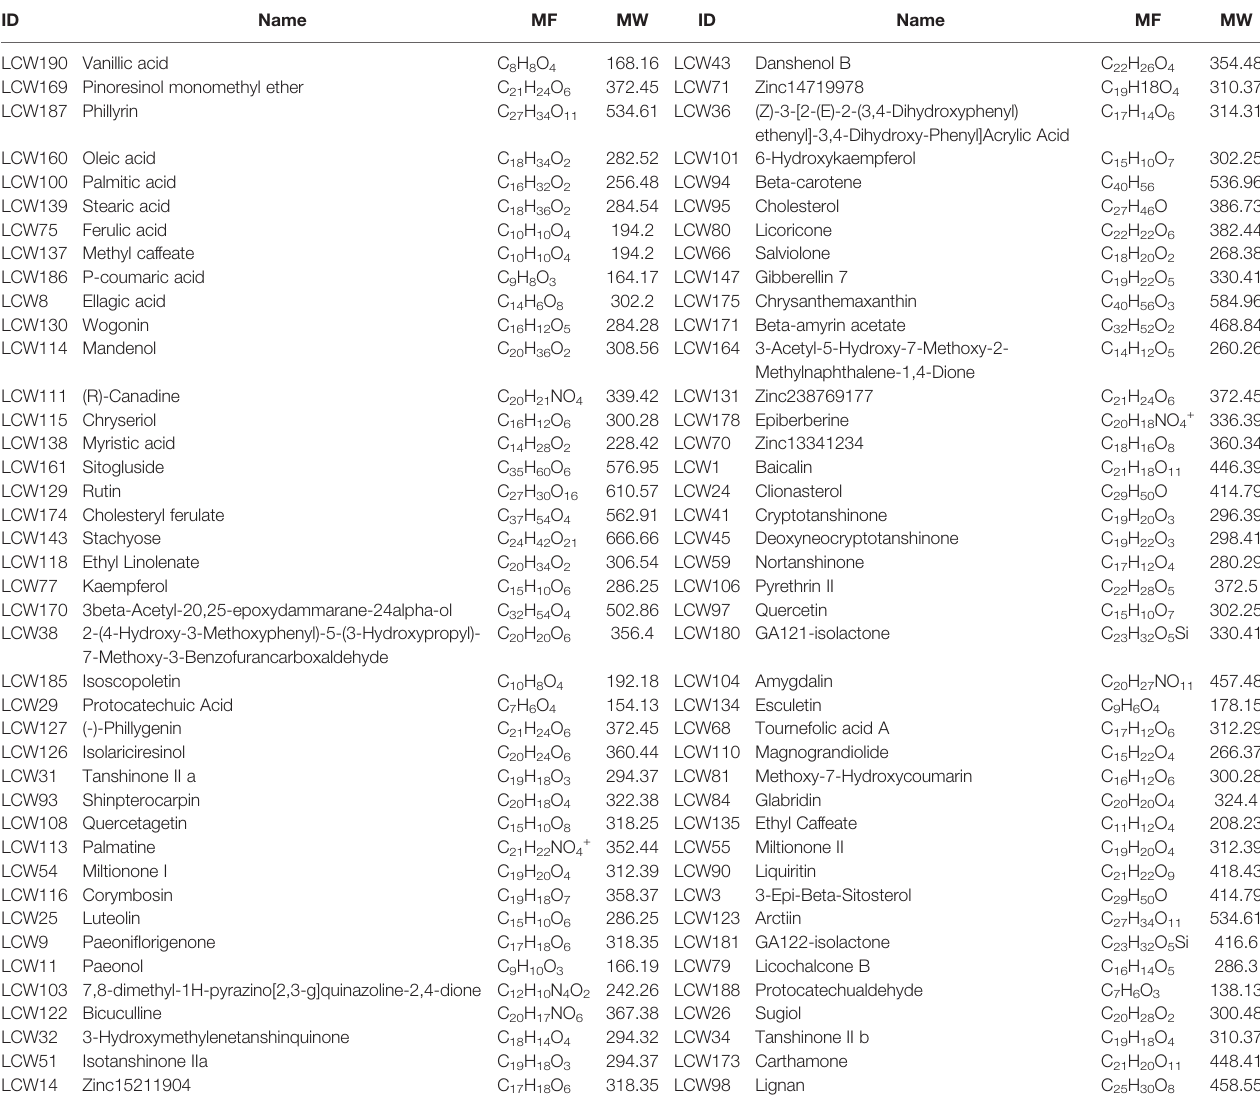
TABLE 3 | The information of selected KGEC in